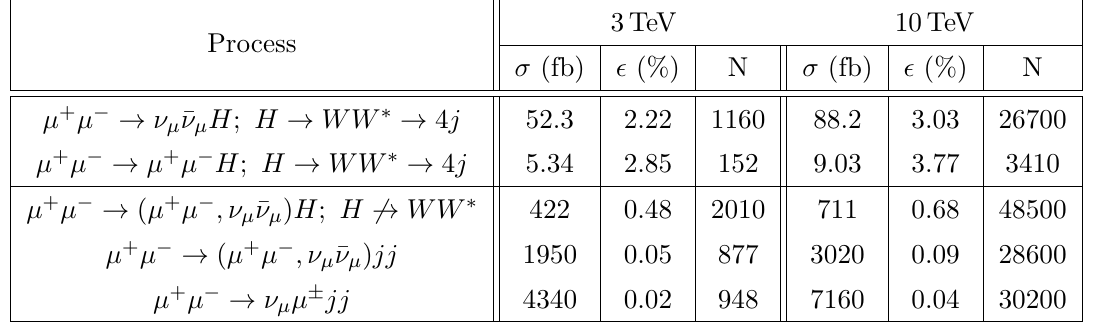
Table 3 . Signal and most important backgrounds for VBF H → WW ∗ → 4 j after applying flavor tagging and analysis cuts. µ + µ − → ( µ + µ − , ν and τ + τ −